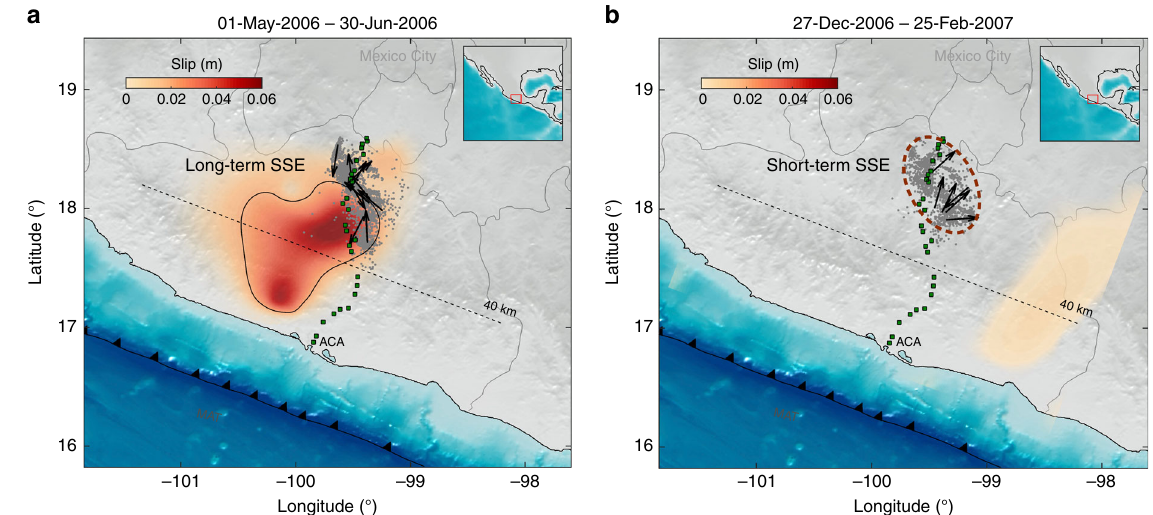
Fig. 4 Slip increments of the 2006 SSE for the periods indicated on top of each panel. Tremor epicenters and RTMs associated with each period are shown in gray dots and black arrows, respectively. While TTs and RTMs shown in panel a correspond to those occurred during a stage of the long-term SSE, panel b shows tremors associated with a slip reactivation (i.e., a short-term SSE, wine dotted line), months later the long-term SSE has moved away from the region. The basemaps were created using SRTM15 + data